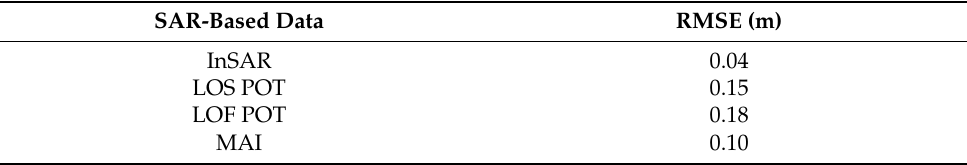
Figure 6. Comparison between LOS-projected GNSS ( red triangles ), InSAR (black diamonds) and POT ( green circles ) measurements ( A ); comparison between LOF-projected GNSS ( red triangles ), MAI ( black diamonds ) and POT ( green circles ) measurements ( B ). In Figure S5 is shown the same analysis performed by histograms comparison. Table 2. RMSE between SAR-based data and GNSS measurements .